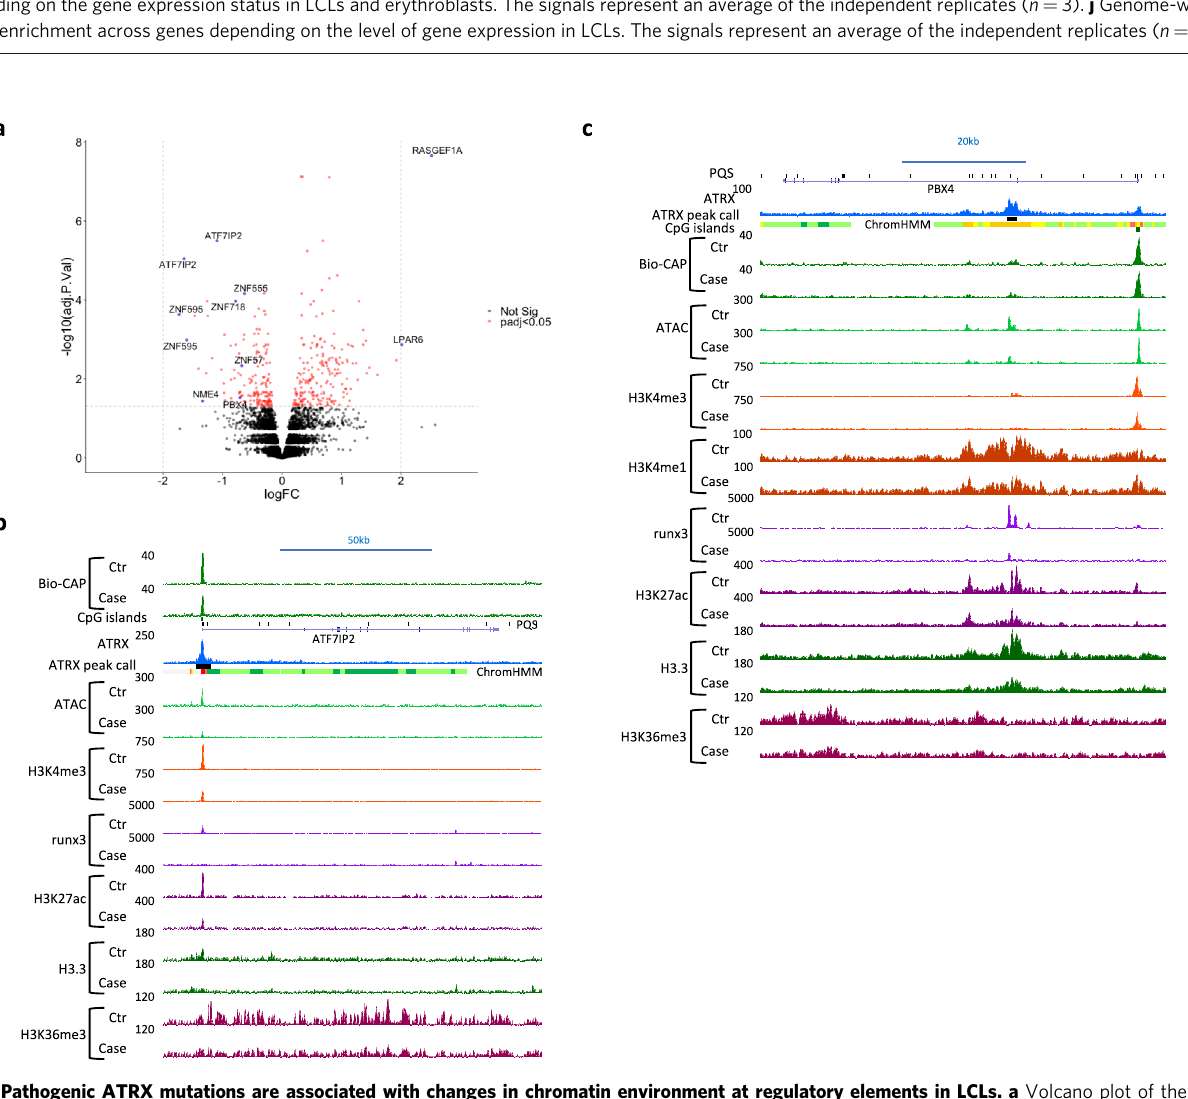
Fig. 3 ATRX enrichment at regulatory elements varies with the activity of the locus and ATRX binding sites conserved across cell lines show conserved chromatin accessibility states. a Distribution of the ATRX binding sites relative to genes in erythroblasts. b Distribution of the ATRX binding sites depending on their chromatin accessibility as assessed by ATAC-seq in erythroblasts. c Motif analysis of ATRX binding sites in erythroblasts (p- values HOMER fi ndMotifsGenome.pl) 58 . d Representative image of the α -globin locus active in erythroblasts and silenced in LCLs. The signals represent an average of the independent replicates (in LCLS, n = 3 for ATRX ChIP-seq, H3K4me1, H3K4me3, H3K27me3 and H3.3 ChIP-seq, n = 2 for H3K27ac ChIP- seq and n = 4 for ATAC-seq. In erythroblasts, n = 3 for ATRX-ChIP-seq, n = 1 for H3K4me1, H3K4me3, H3.3 and H3K27me3 and n = 4 for ATAC-seq). e Venn diagram showing the cell type-speci fi c and conserved ATRX binding sites in LCLs and erythroblasts. f Distribution of the conserved ATRX binding sites based on their position in relation to genes. g Chromatin accessibility status in LCLs and erythroblasts at the conserved ATRX binding sites. h Distribution of the conserved ATRX binding sites based on the presence or absence of PQS. i Genome-wide ATRX enrichment across genes in LCLs depending on the gene expression status in LCLs and erythroblasts. The signals represent an average of the independent replicates ( n = 3). j Genome-wide